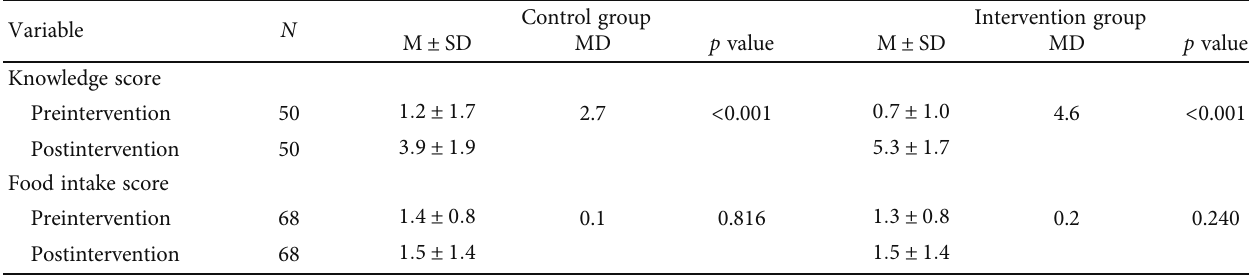
Table 5: Knowledge and iron-rich food intake scores within the study groups.